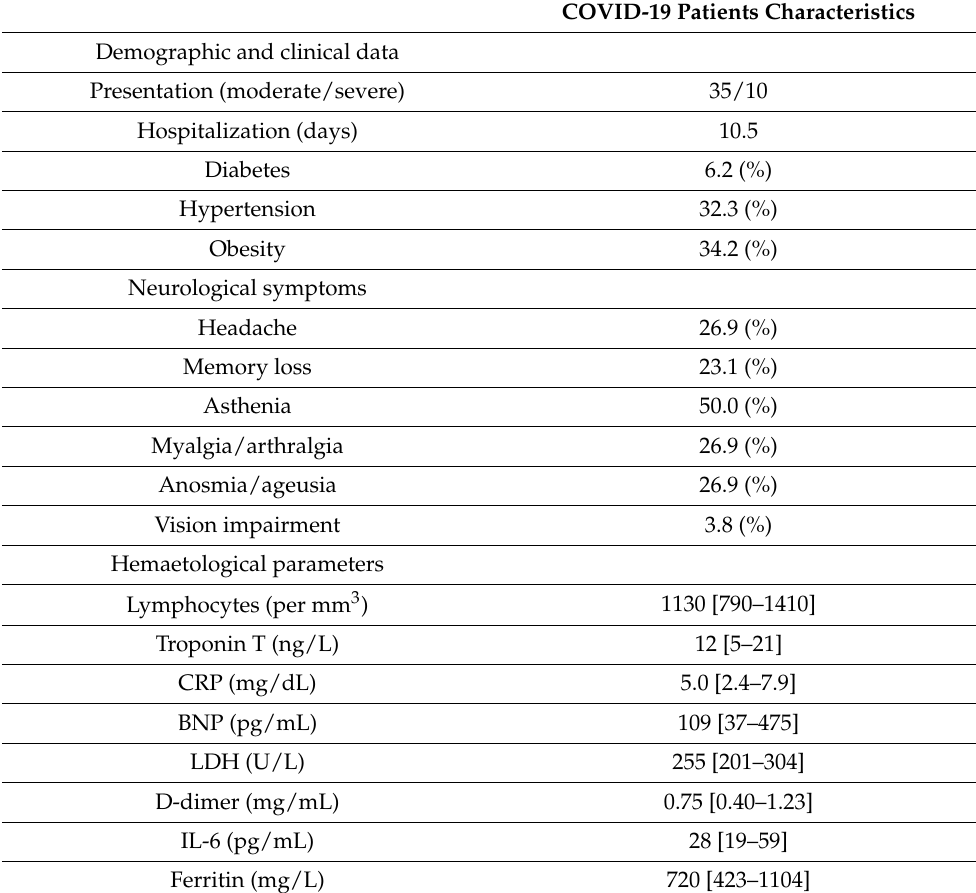
Table 1. Characteristics of the COVID-19 patients at the acute phase of